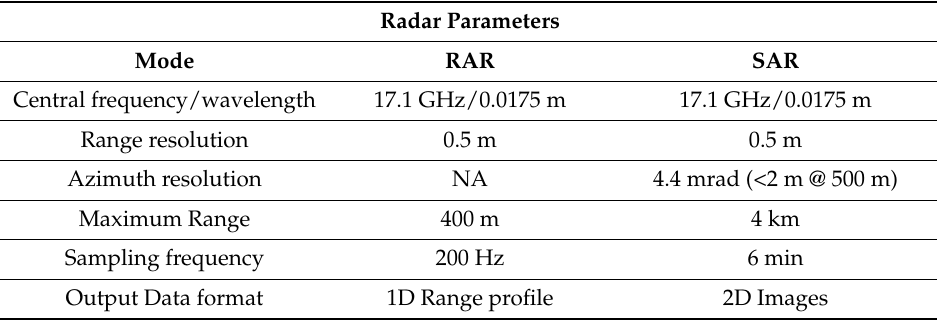
Table 1. Main parameters of the radar transceiver used to acquire RAR and GB-SAR data,